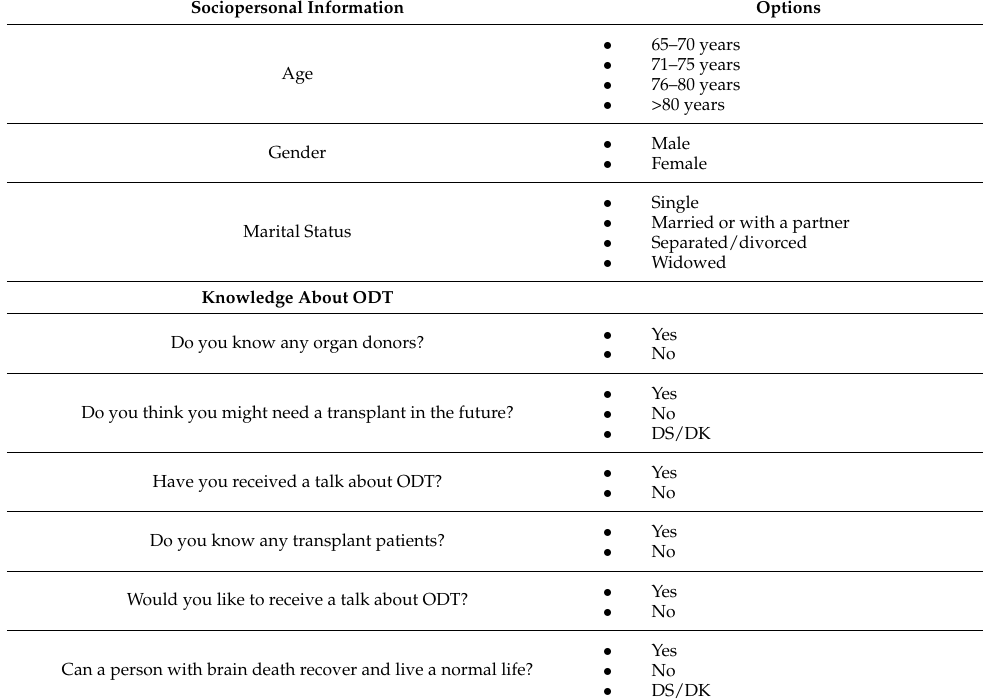
Table 1. Validated questionnaire about attitude toward